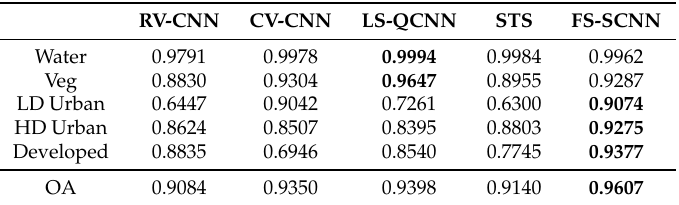
Table 2. Classification accuracy comparisons on San Francisco.